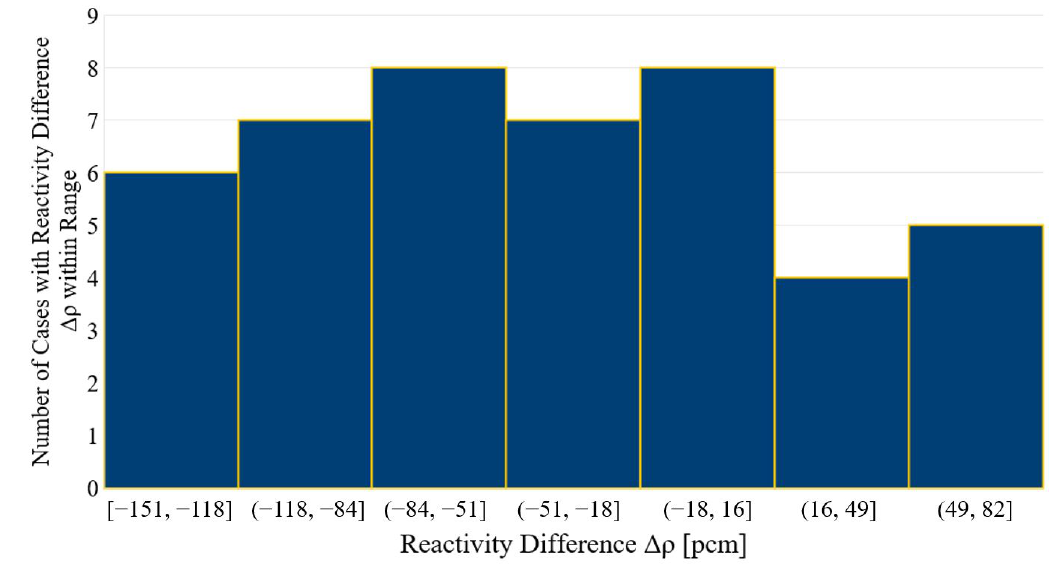
Figure 8. Histogram of Reactivity Differences for Single Fuel Pin